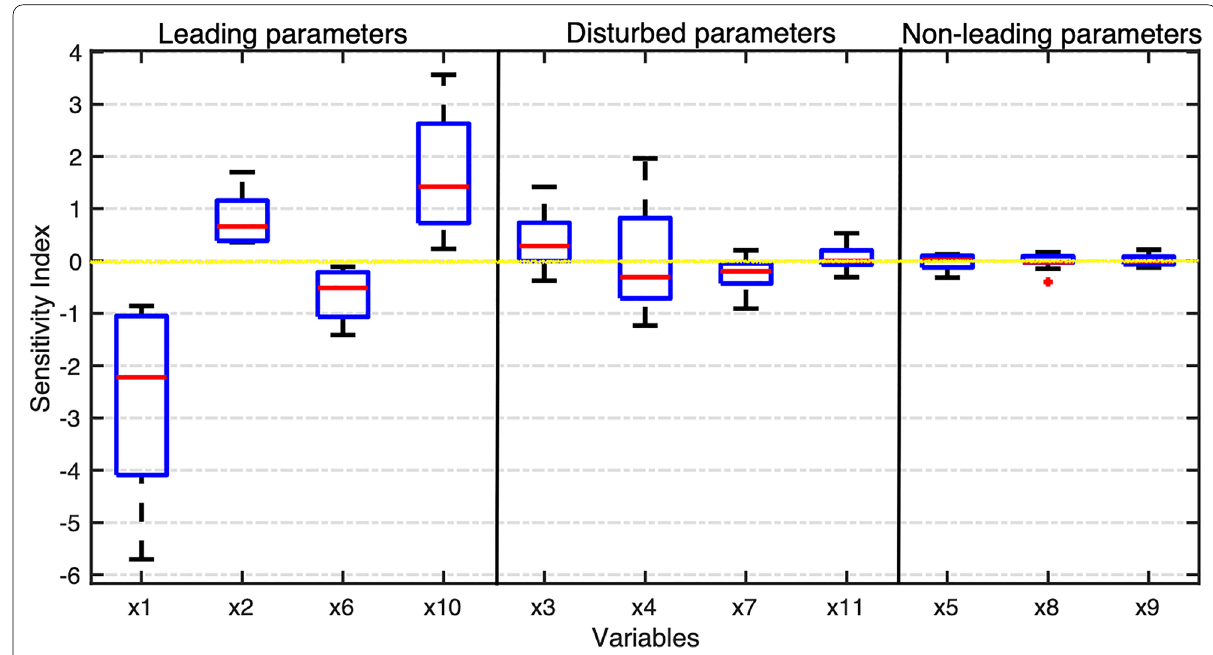
Figure 5 Effects of the leading inputs on the output